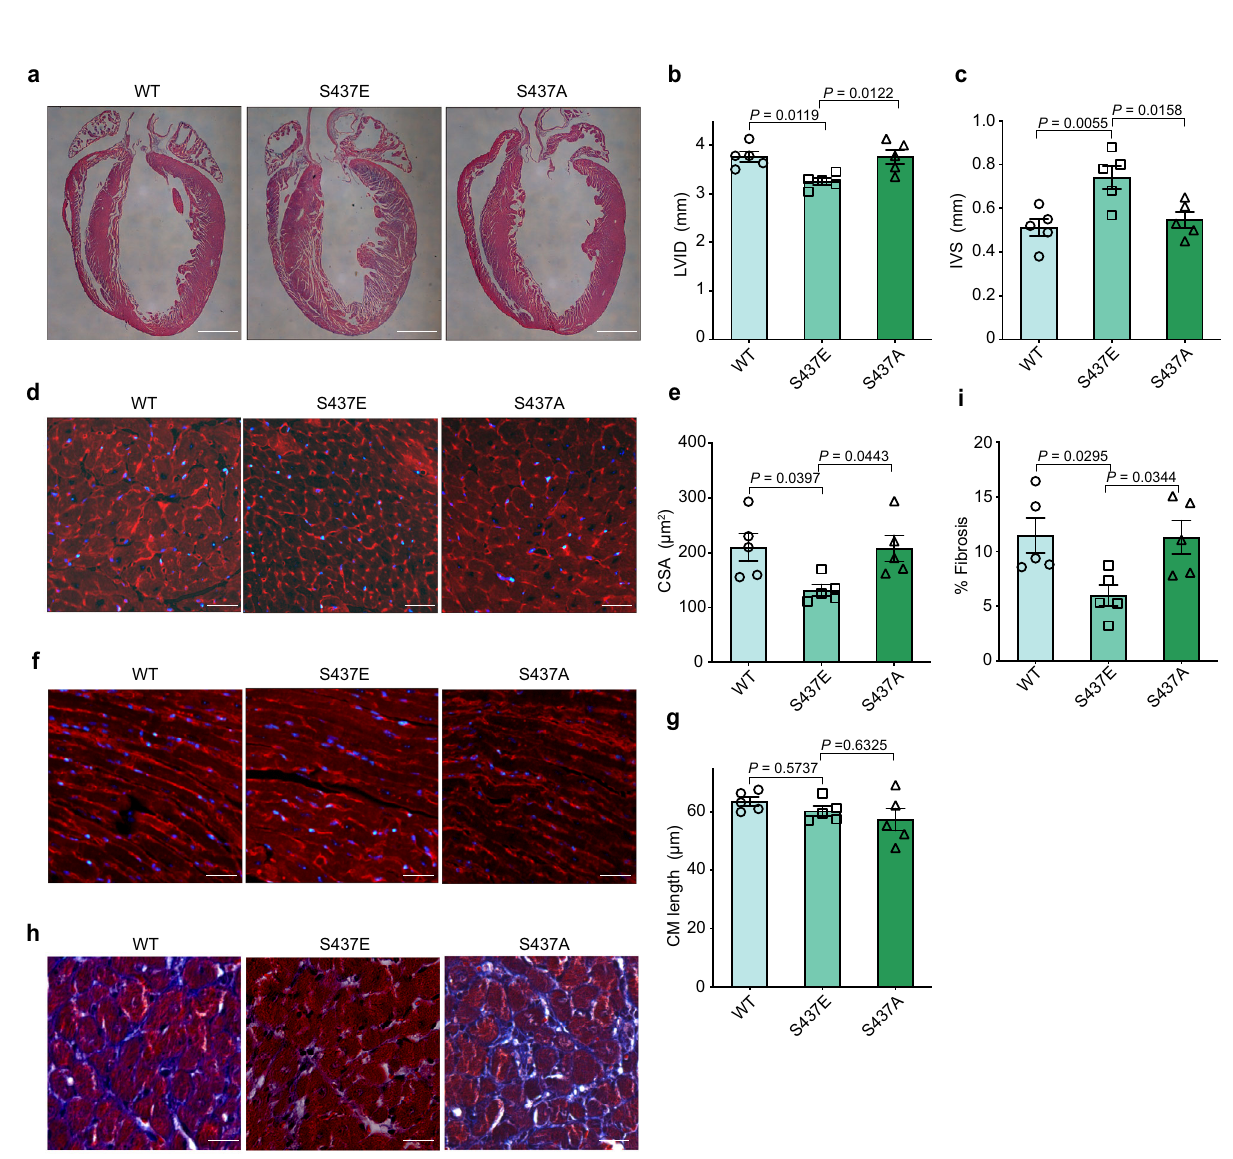
h , i Masson ’ s trichrome staining of heart sections and quanti fi cationofmyocardial fi brosis. Scale bar: 50 μ m. For all panels, n =5 animal per group. All statistical analyseswereperformedusingone-wayANOVAandDunnettmultiplecomparisons test. Data are presented as the means ± S.E.M.; P values are shown in each graph. Source data are provided as a Source Data fi